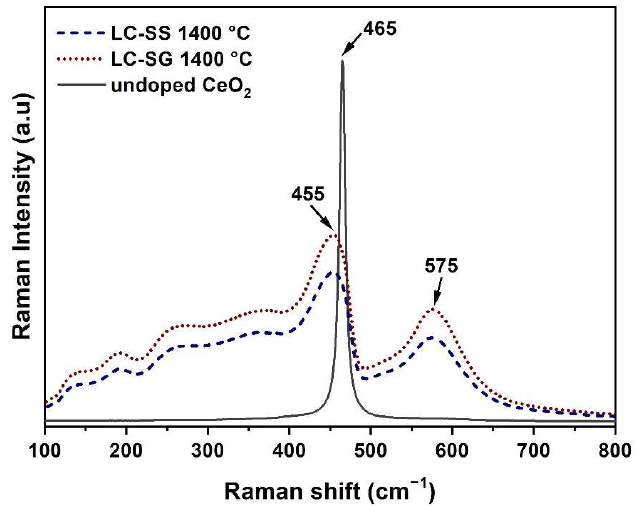
Figure 5. Raman spectra of the LC powders calcined at 1400